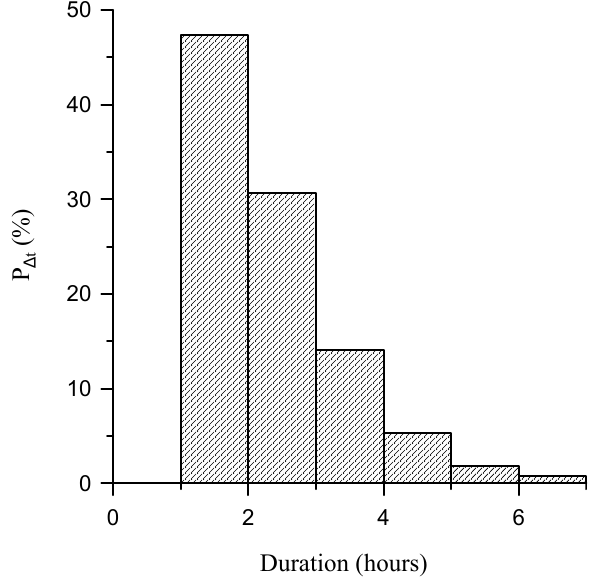
Fig. 6. The statistical distribution of NETE durations in 1-h bins.